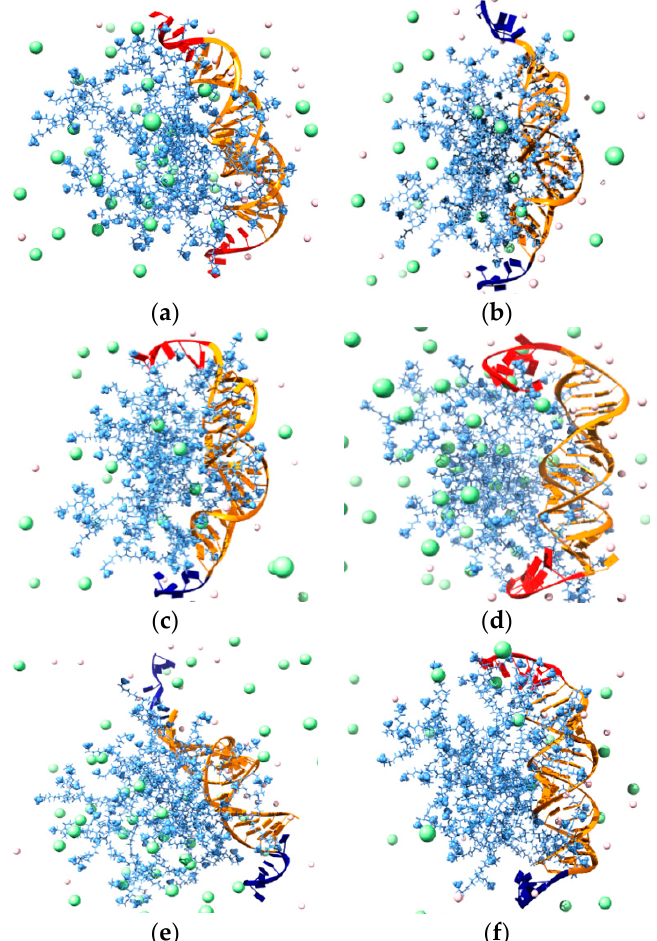
Figure 12. Examples of equilibrated molecular dynamics (MD) snapshots of G 5 TEA-core dendrimer in complex with A 5 / A 5 ( a ), T 5 / T 5 ( b ), A 5 / T 5 ( c ), A 7 / A 7 ( d ), T 7 / T 7 ( e ), and A 7 / T 7 ( f ) ssiRNAs at pH 7.4 and in the presence of 0.15 M NaCl. In all panels, the dendrimer is shown as cornflower blue sticks, and the terminal charged amine groups are highlighted as sticks-and-balls. The ssiRNA is portrayed as an orange ribbon, with the two overhangs (A n ) and (T n ) colored in red and navy blue, respectively. Some Cl − and Na + ions and counterions are shown as light green and light pink spheres, respectively. Water molecules are not shown for clarity. Redrawn from [57], with permission of the American Chemical Society.